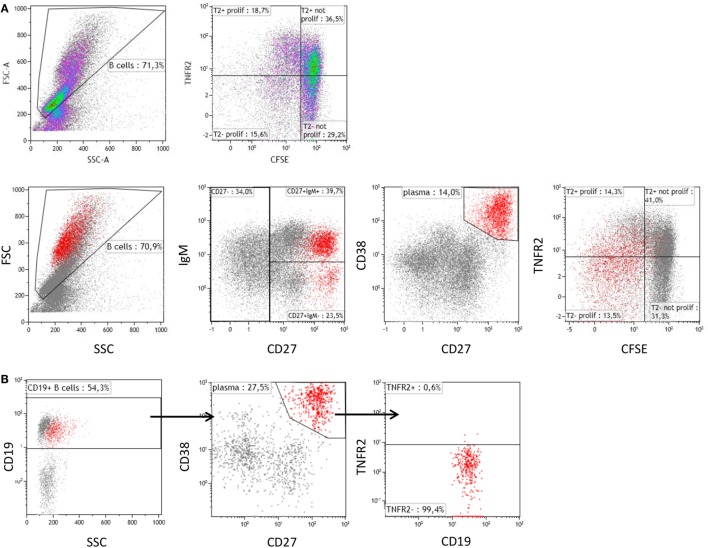
Tumor necrosis factor receptor 2 (TNFR2) expression on proliferating B cells and plasma cells. (A) On day 4 after stimulation with CpG ODN, TNFR2 expression was analyzed on proliferating B cells and plasma blasts (CD38high CD27high highlighted in red). B cell proliferation was visualized by CFSE dilution. Data from one representative donor of four are shown. FSC: Forward scatter; SSC: Side scatter. (B) Plasma cells were enriched by isolation of CD138+ cells from peripheral blood and stained for TNFR2 expression. The results obtained from one representative of four independent donors are provided.